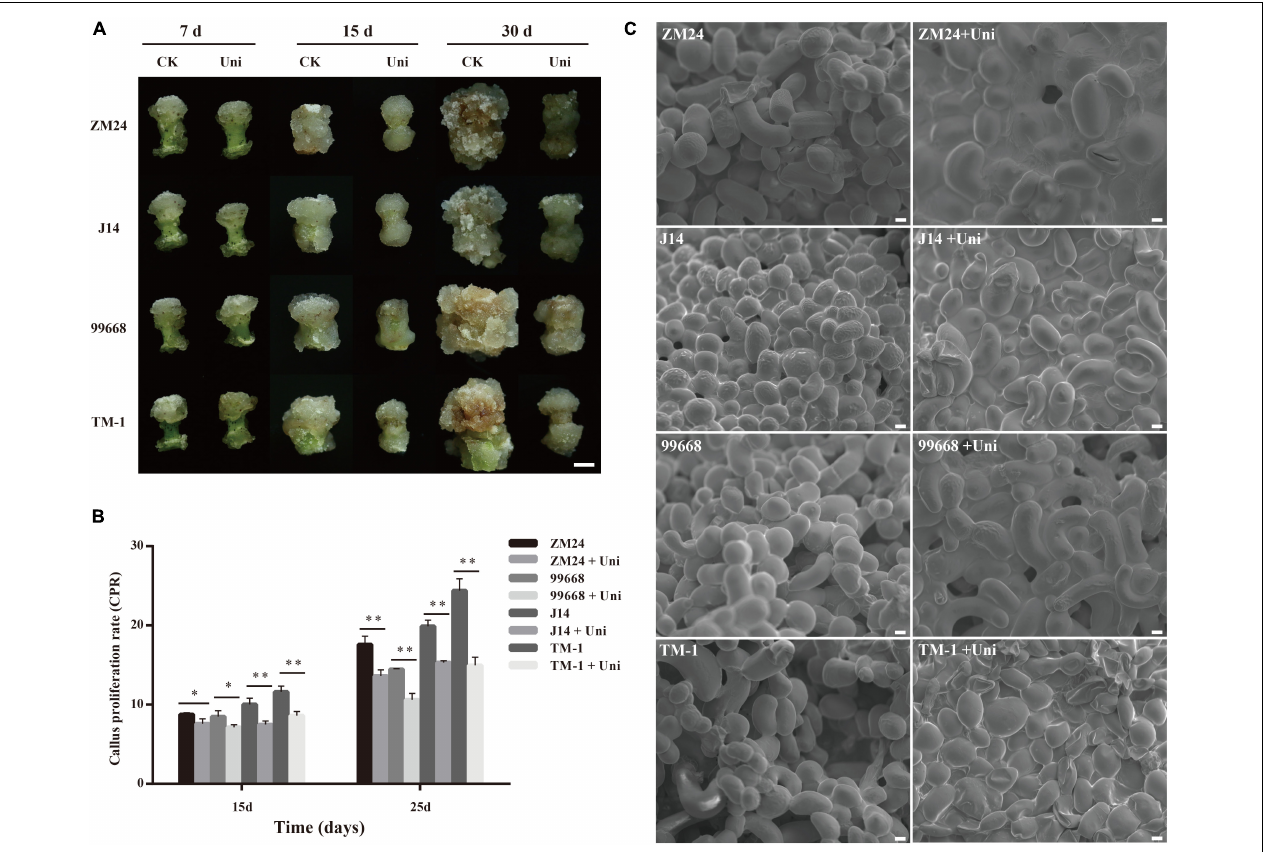
FIGURE 1 | Effects of uniconazole on callus proliferation and callus cell morphology in Gossypium hirsutum cv ZM24, J14, 99,668, and TM-1. (A) The phenotype of callus after cultured for 7, 15, and 30 days on callus-induction medium without the supplementation of uniconazole (CK) and those with uniconazole (Uni). Scale bar = 5 mm. (B) The scanning electron microscopy images of callus cells of ZM24, J14, 99,668, and TM-1, at 30-day induction. Scale bar = 20 µ m. (C) Callus proliferation rate (CPR) recorded after culturing for 15 and 25 days. The single asterisk indicates statistical significance at p < 0.05. The double asterisk indicates statistical significance at p <